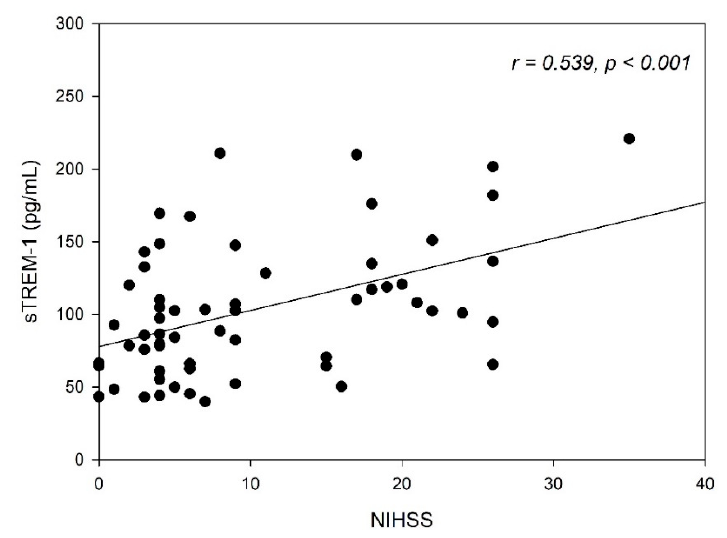
Figure 1. Serum levels of the soluble triggering receptor expressed on myeloid cells-1 (sTREM-1) in acute ischemic stroke patients, which are significantly correlated with the National Institutes of Health Stroke Scale (NIHSS).